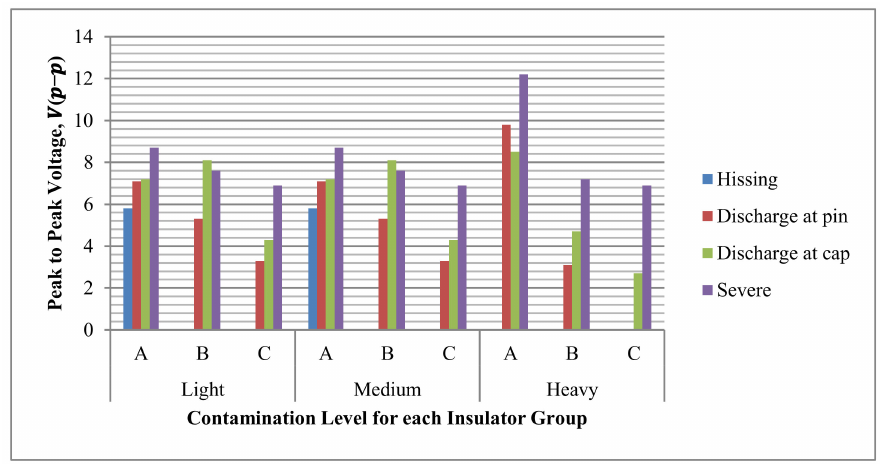
Figure 13. Average peak-to-peak voltage for each contamination level and insulator group for wet